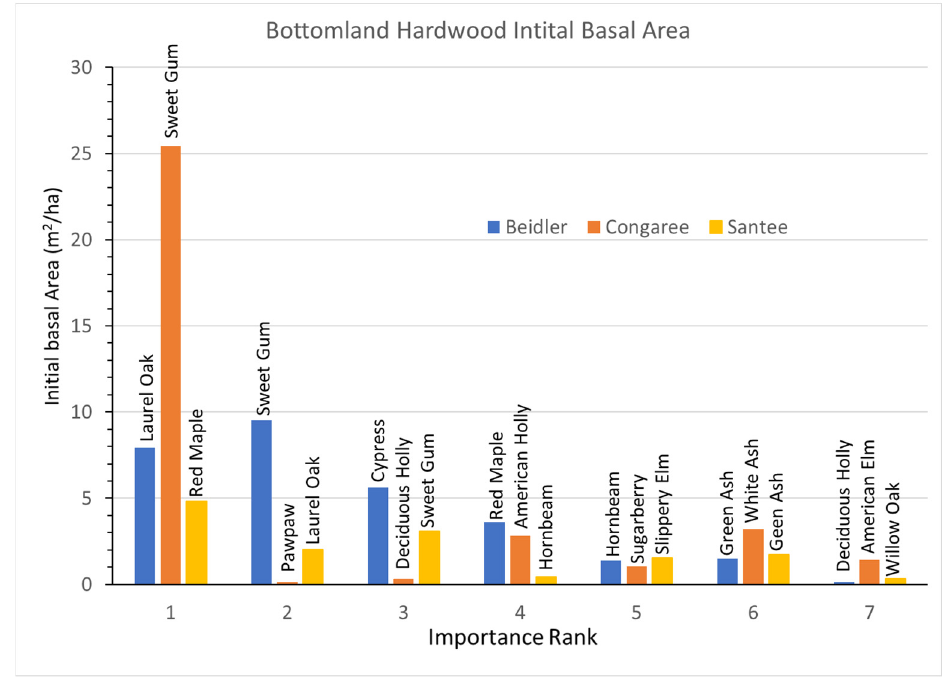
Figure 7. Distribution of initial basal area of species, by importance factor (1 means the most important, while 7 means the least important), for each study site of the bottomland hardwood vegetation type.